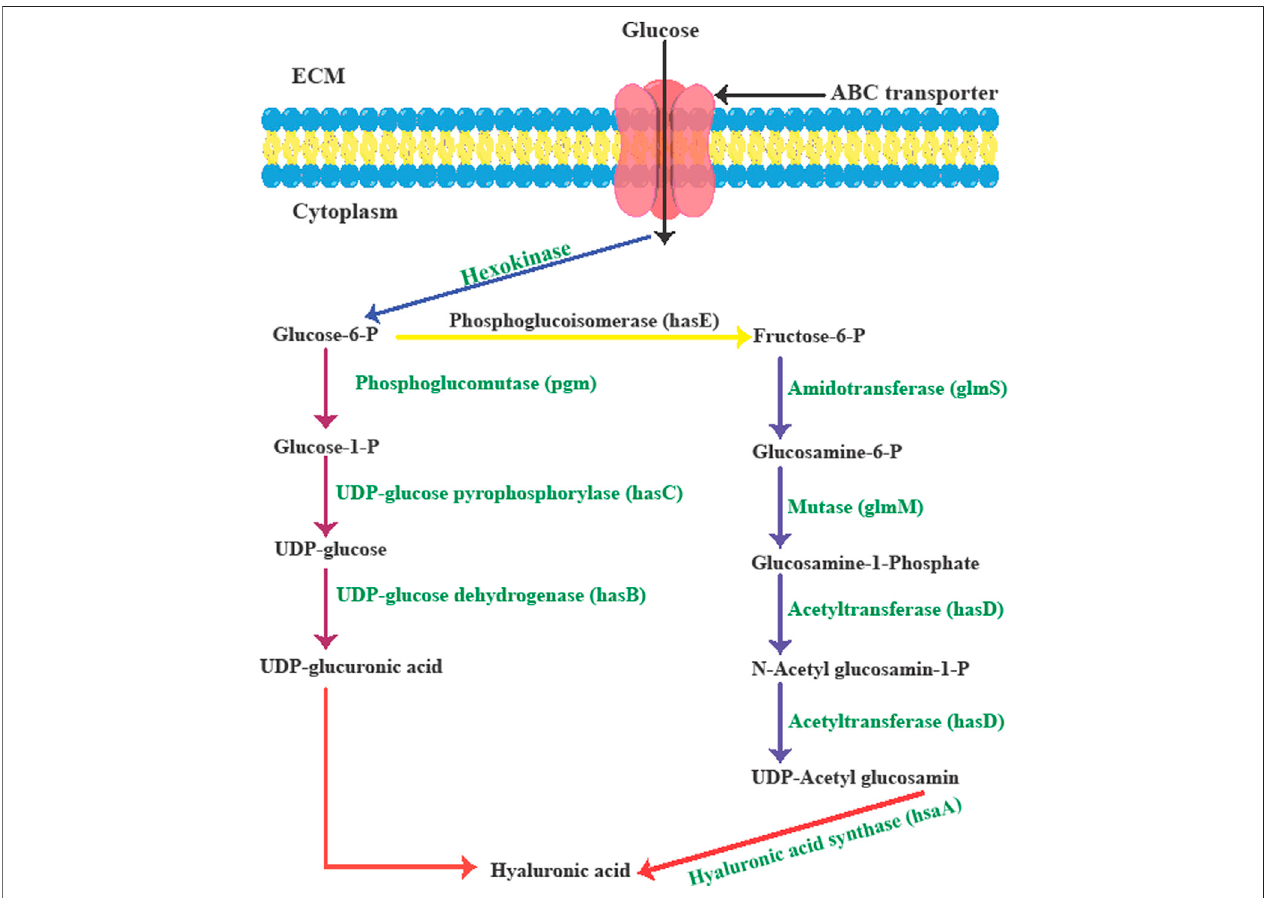
FIGURE 2 | The biological synthesis pathway of hyaluronic acid in Streptococcus zooepidemicus . Adapted from Ref (Sze et al., 2016b) with changes.